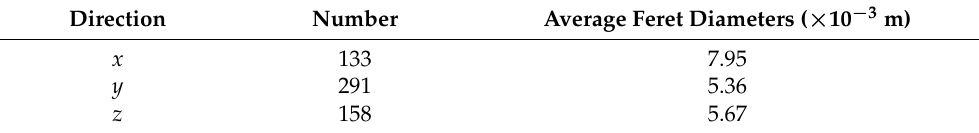
Table 1. Number of cell size measurements and average Feret diameters for different directions.